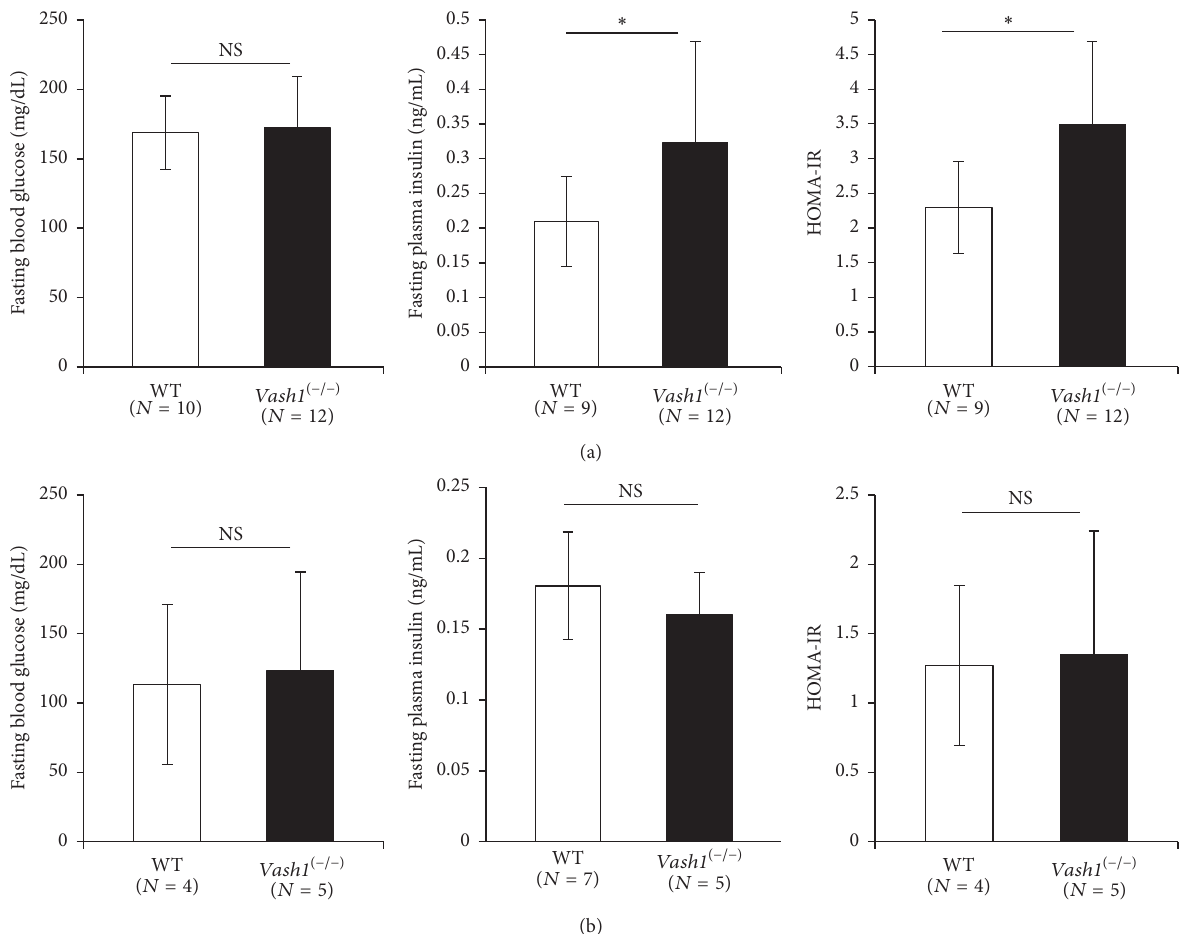
Figure 2: Insulin resistance in young vash1 −/− mice. Fasting blood glucose, fasting plasma insulin, and HOMA-IR are compared between WT and vash1 −/− of young (a) and old (b) male mice. Means ± SDs are shown. The statistical significance of differences was calculated by use of unpaired Student’s 𝑡 -test, and a value of 𝑝 < 0.05 was the criterion for significance. ∗ 𝑝 < 0.05